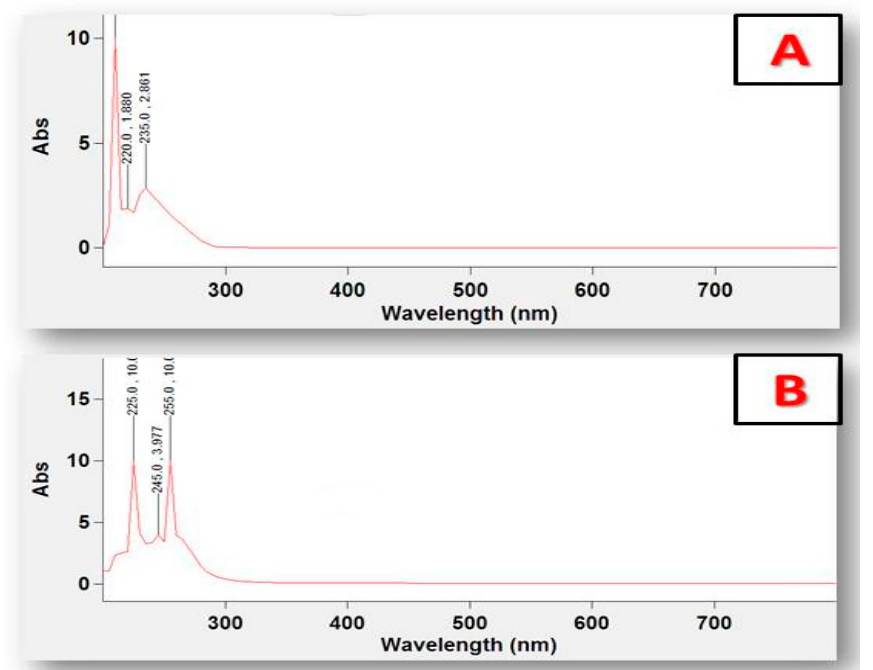
Figure 5. UV–Vis spectra of ( A ) PRD and ( B ) PRD/Zn. Table 1. Electronic spectra and magnetic moments of free ligand prednisolone, and its zinc com- plex.